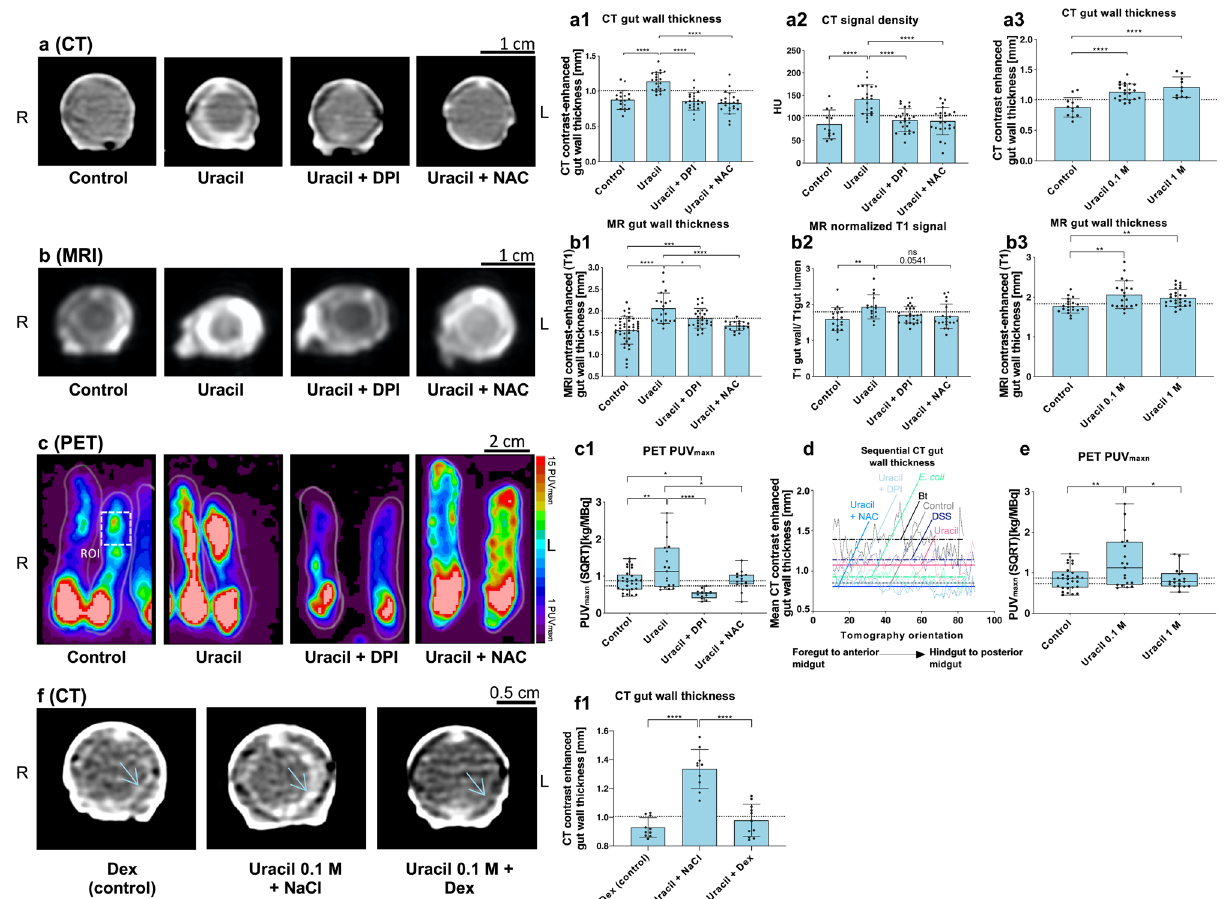
Fig. 8 | High-throughput screening ofanuracil-induced and DUOX-dependent colitis-like phenotype. a – c High-throughput CT, MRI, and FDG-PET reveal an uracil-induced colitis-like phenotype, which is ameliorated by the DUOX inhibitor diphenyleneiodonium (DPI) or the ROS scavenger N-acetylcysteine (NAC), a1 : n =85,one-wayANOVA, F (3,81)=23.77, R 2 =0.4682, P <0.0001, a2 : n =79,one-way ANOVA, F (3,875)=14.6, R 2 =0.3687, P <0.0001, b1 : n =107, one-way ANOVA, F (3,103)=16.45, R 2 =0.3239, P <0.0001, b2 : n =80, one-way ANOVA, F (3,76)=4.016, R 2 =0.1368, P =0.0104 and c1 : n =75, one-way ANOVA, F (3,71)=9.627, R 2 =0.2892, P <0.0001. a3 , b3 , and e Concentration-dependent effect of DUOX (activated by uracil) and successive worsening of the colitis-like phenotype a3 : n =44, one-way ANOVA, F (2,41)=16.48, R 2 =0.4457, P <0.0001, b3 : n =67, one-way ANOVA, F (2,64)=6.809, R 2 =0.1755, P =0.0136 and E: n =66, one-